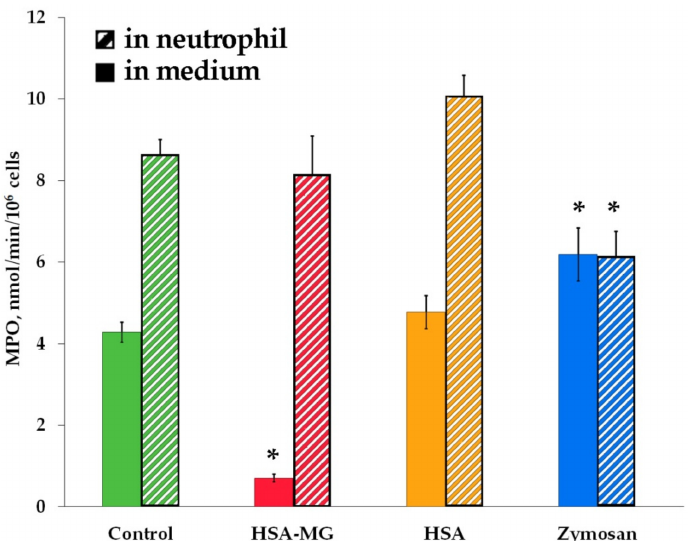
Figure 10. Level of MPO in neutrophils and in extracellular medium after cell incubation with HSA or HSA-MG compared with zymosan. Cells were incubated in bicarbonate Krebs-Ringer buffer solution (pH 7.4) supplied with 1.3 mM CaCl 2 and 2% autologous blood plasma for 30 min at 37 ◦ C. Each probe contained 2.3 × 10 6 cells/mL, 1 mg/mL HSA or HSA-MG or zymosan, and 150 mM NaCl was added to control samples. * p < 0.05 compared to control. All measurements were performed in triplicate ( n = 3).